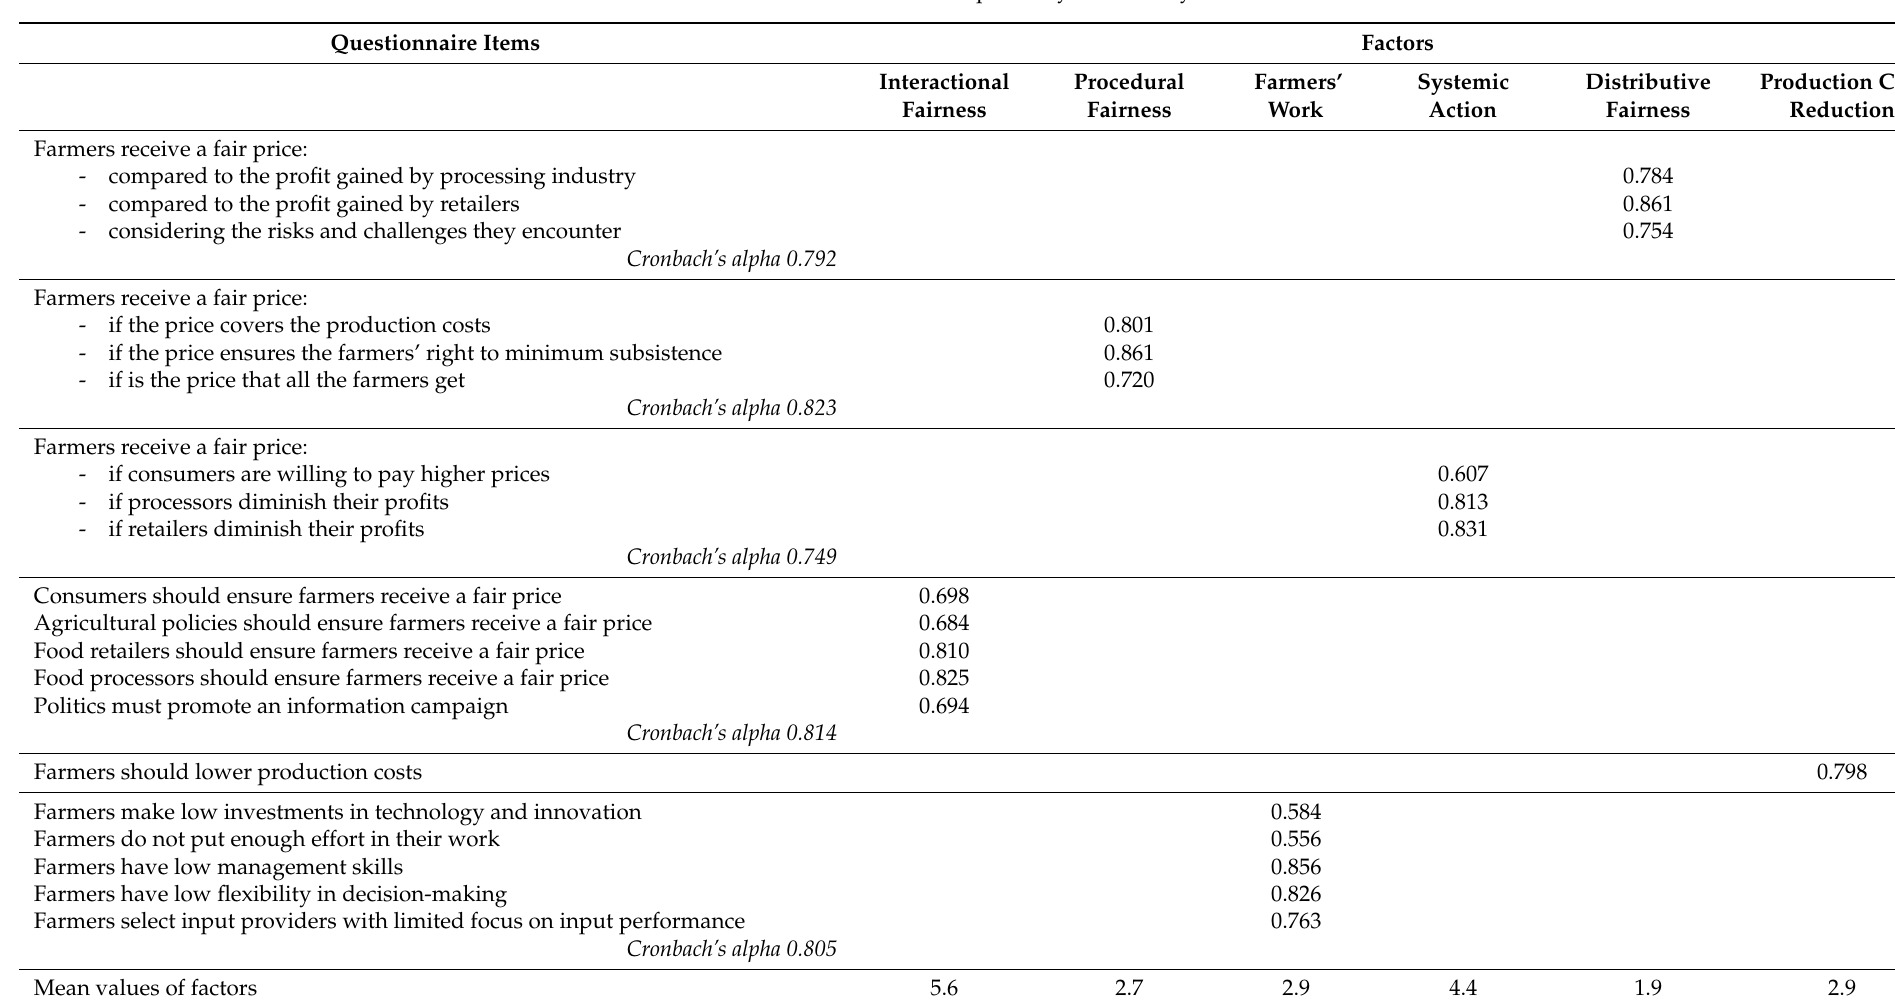
Table 6. Result of the exploratory factor